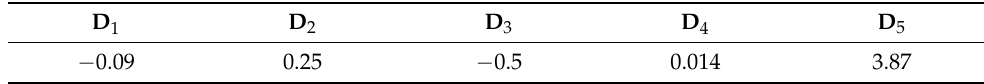
Table 5. Johnson–Cook damage model parameters for Ti6Al4V [26].